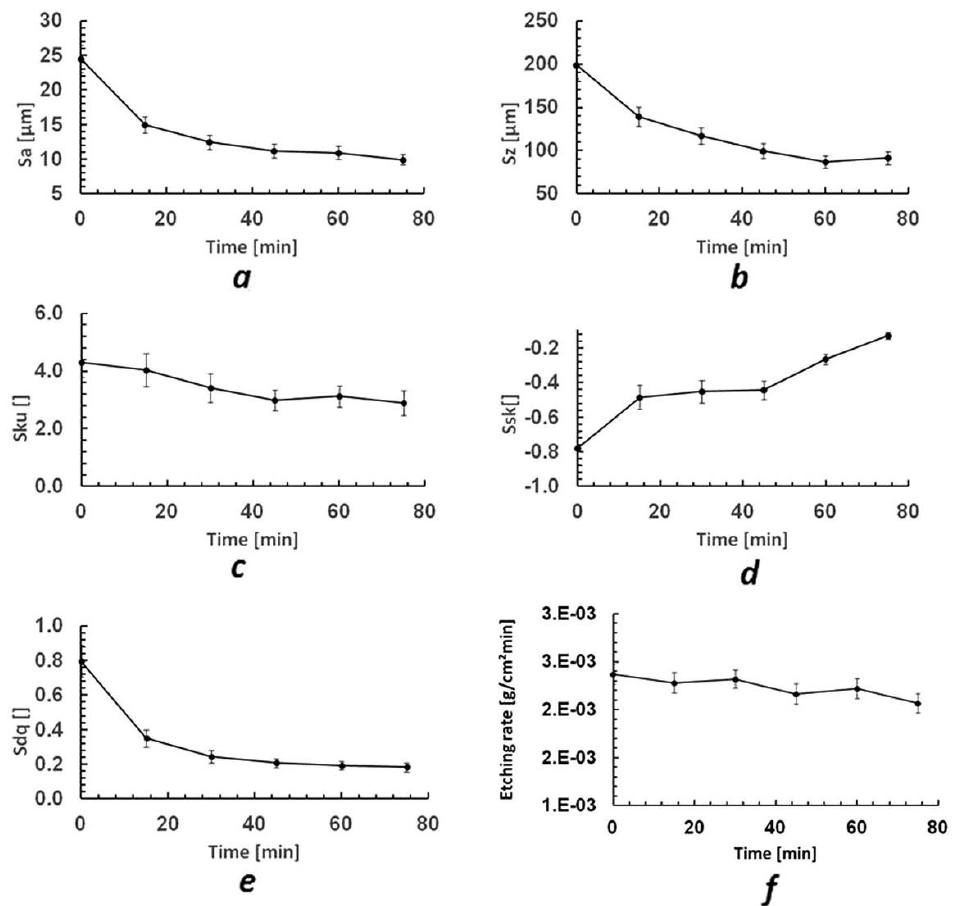
Figure 23. Effect of chemical machining on ( a ) surface roughness, ( b ) ten-point height, ( c ) kurtosis, ( d ) skewness, ( e ) peaks and valleys symmetrical distribution, and ( f ) etching rate [95]; with permission from Elsevier.